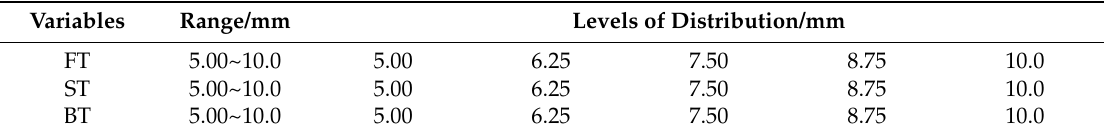
Table 3. The levels of distribution of each volute panel thickness. FT: the front panel thickness, ST: the side panel thickness, BT: the back panel